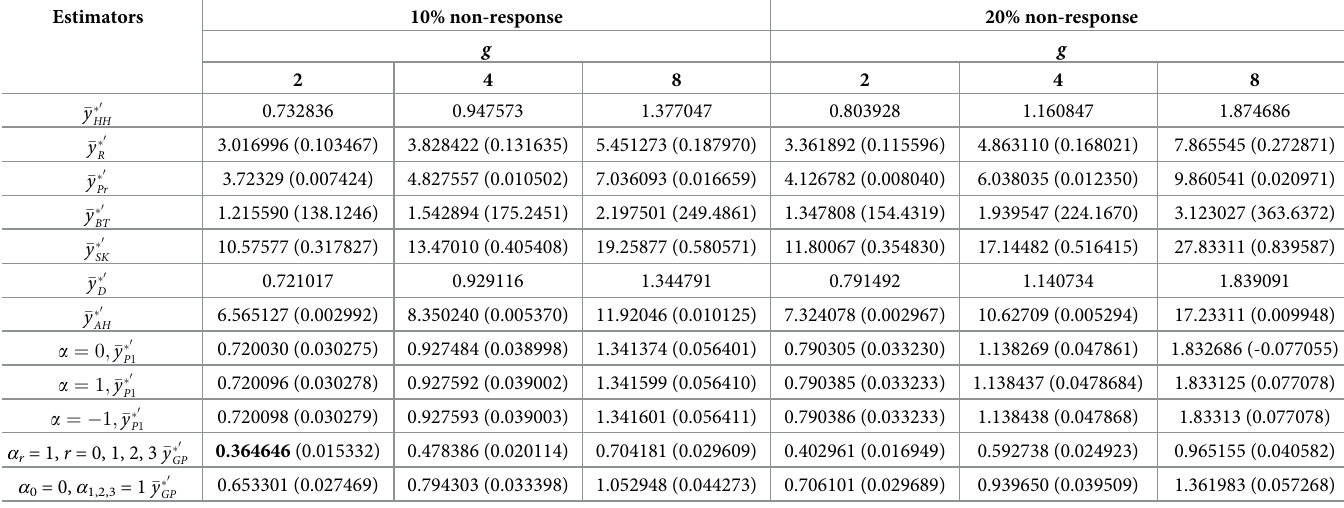
Table 14. Mean squared error and | Bias | (in brackets) values for different estimators for Population VI without measurement error.